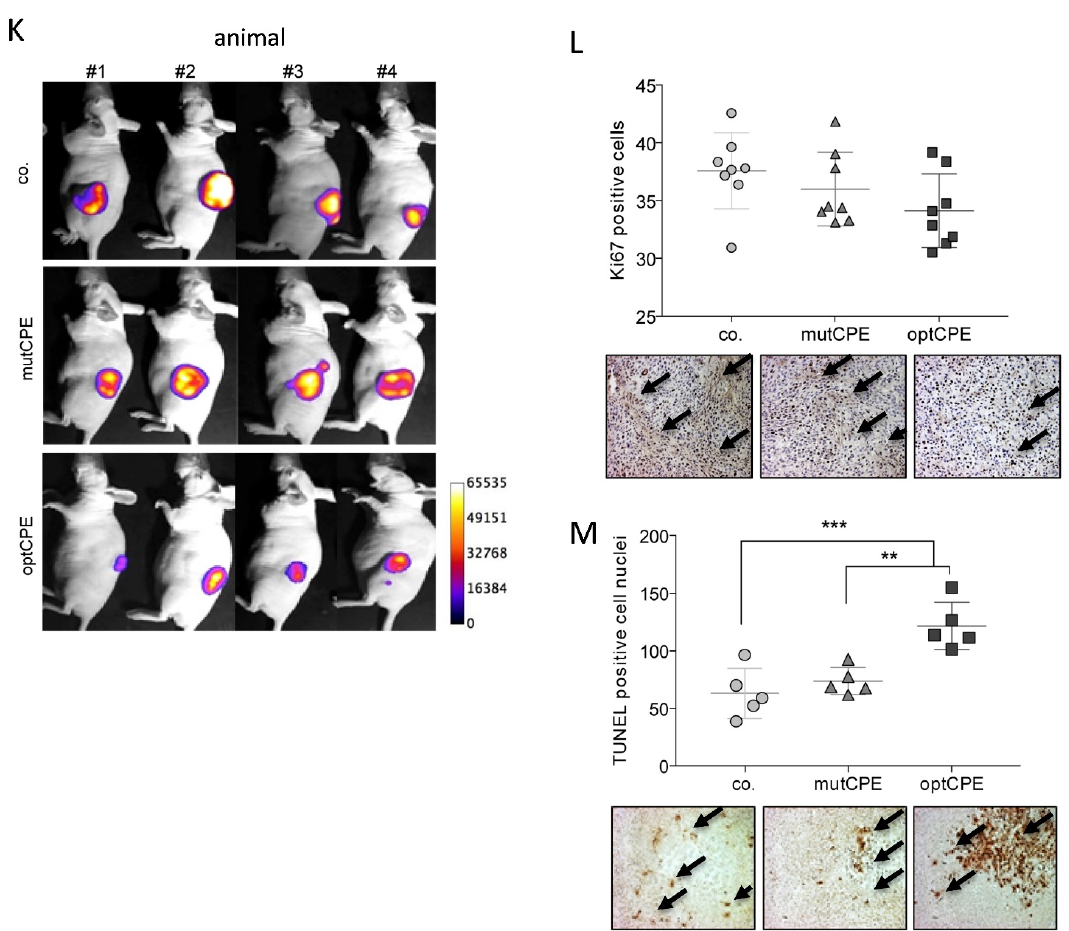
Figure 6. Therapeutic efficacy of non-viral in vivo optCPE gene transfer. ( A ) 34 days after cell injection of optCPE gene transfer (GT) was performed. By this, significant inhibition of tumor viability (determined by bioluminescence; BL), and ( B ) tumor growth (measured via mean tumor volume) was observed in MIA PaCa-2/eGFP-Luc bearing mice compared to VC-transfected animals. ( C ) Decrease of BL in optCPE-transfected tumors compared to controls, shown in representative images. ( D ) Ex vivo tumor BL showed significantly reduced tumor viability at day 39. Data represent mean values ± S.E.M. ( n = 10). ( E ) Reduction of tumor viability of Capan-1/eGFP-Luc CDX tumors (determined by tumor BLI) was observed after intratumoral optCPE gene transfer (performed 26 days after cell injection). ( F ) Mean tumor volume was not affected by intratumoral optCPE expression. ( G ) Decrease of BL in optCPE-transfected CDX tumors compared to respective vector control (VC), shown by representative images. ( H ) At day 36 ex vivo tumor BL was determined ( n = 7), showing significantly reduced viability. ( I ) After intratumoral optCPE gene transfer (performed 23 days after tumor cell injection), significant antitumoral efficacy was shown in PA-TU-8902/eGFP-Luc CDX-bearing mice. Tumor viability (determined by tumor BL) decreased significantly in optCPE-expressing tumors compared to empty vector control (VC) or the non- Cldn3/4 binding CPE (mutCPE) expressing tumors. ( J ) Similarly, in vivo optCPE gene transfer significantly inhibited of PA-TU-8902/eGFP-Luc CDX tumor growth compared to VC or mutCPE gene transfer, respectively. ( K ) Tumor BL revealed reduced tumor viability by reduction of BL signals in optCPE-transfected CDX tumors compared to respective controls, shown in representative images. ( L ) Ki67 analysis (brown staining, indicated by arrows) shows decrease in optCPE-transfected groups (not significant). ( M ) In optCPE-transfected PA-TU-8902/eGFP-Luc CDX tumors TUNEL assay shows significantly increased number of TUNEL positive nuclei (brown staining, indicated by arrows) compared to mutCPE or VC-transfected tumors. All data represent mean values ± S.E.M. ( n = 8). The level of significance was determined using One way ANOVA based on one characteristic or factor (different treatments) or Two way-ANOVA based on multiple characteristics (e.g., different treatments at different time points) and Turkey’s multiple comparison post-test or the nonparametric Mann-Whitney U-test based on comparison of two groups. (n.s. not significant; * p < 0.05; ** p < 0.01; *** p < 0.001; **** p =